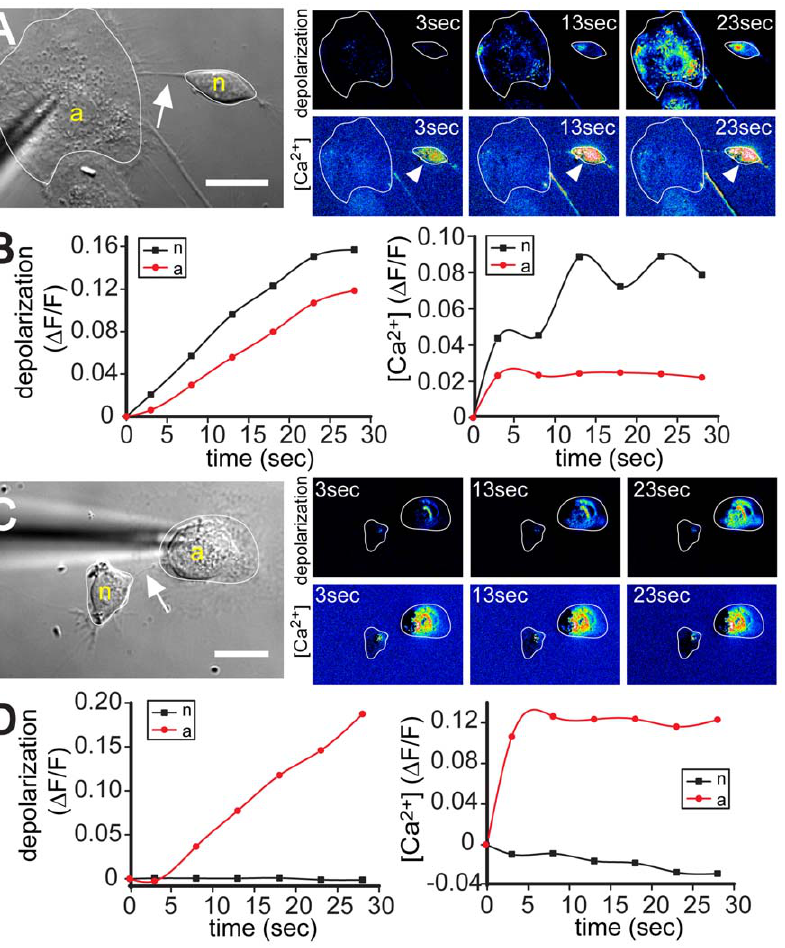
Figure 5. TNTs transmit depolarization and calcium signals to neurons. ( A, C ) The DIC images show the mechanically stimulated astrocytes (‘‘a’’), neurons (‘‘n’’), and the TNTs ( arrows ). The pseudo-colored intensity images, generated by subtraction of the image before stimulation, depict the fluorescence changes of DiBAC 4 (3) ( upper right panel ) and X-rhod-1 ( lower right panel ) at indicated times after mechanical stimulation. ( B ) Quantitative analysis of (A) demonstrates depolarization of the TNT-connected neuron ( left , black curve ) and the resultant increase in intracellular [Ca 2 + ] i ( right, black curve ). ( D ) Quantitative analysis of (C) shows that the TNT-connected neuron was neither depolarized ( left, black curve ) nor exhibited increased [Ca 2 + ] i ( right , black curve ). Scale bars=20 m m.